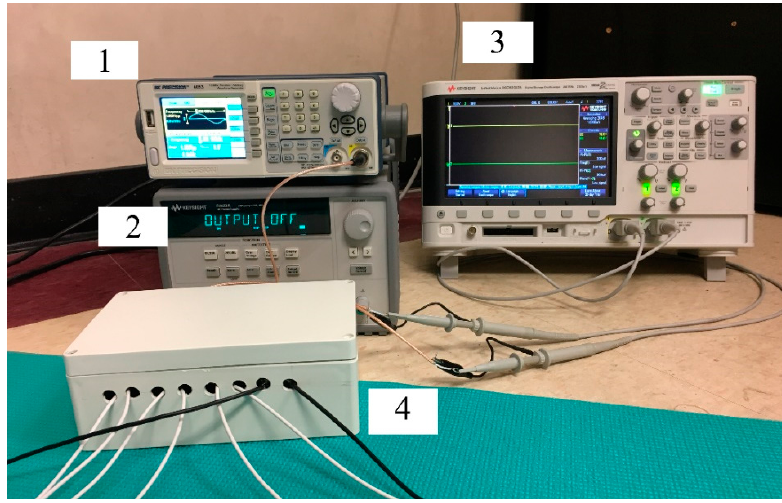
Figure 1. Test equipment and the segmental bioelectrical impedance spectroscopy device (SBISD): (1) signal generator, (2) power supply, (3) digital oscilloscope, and (4) SBISD.